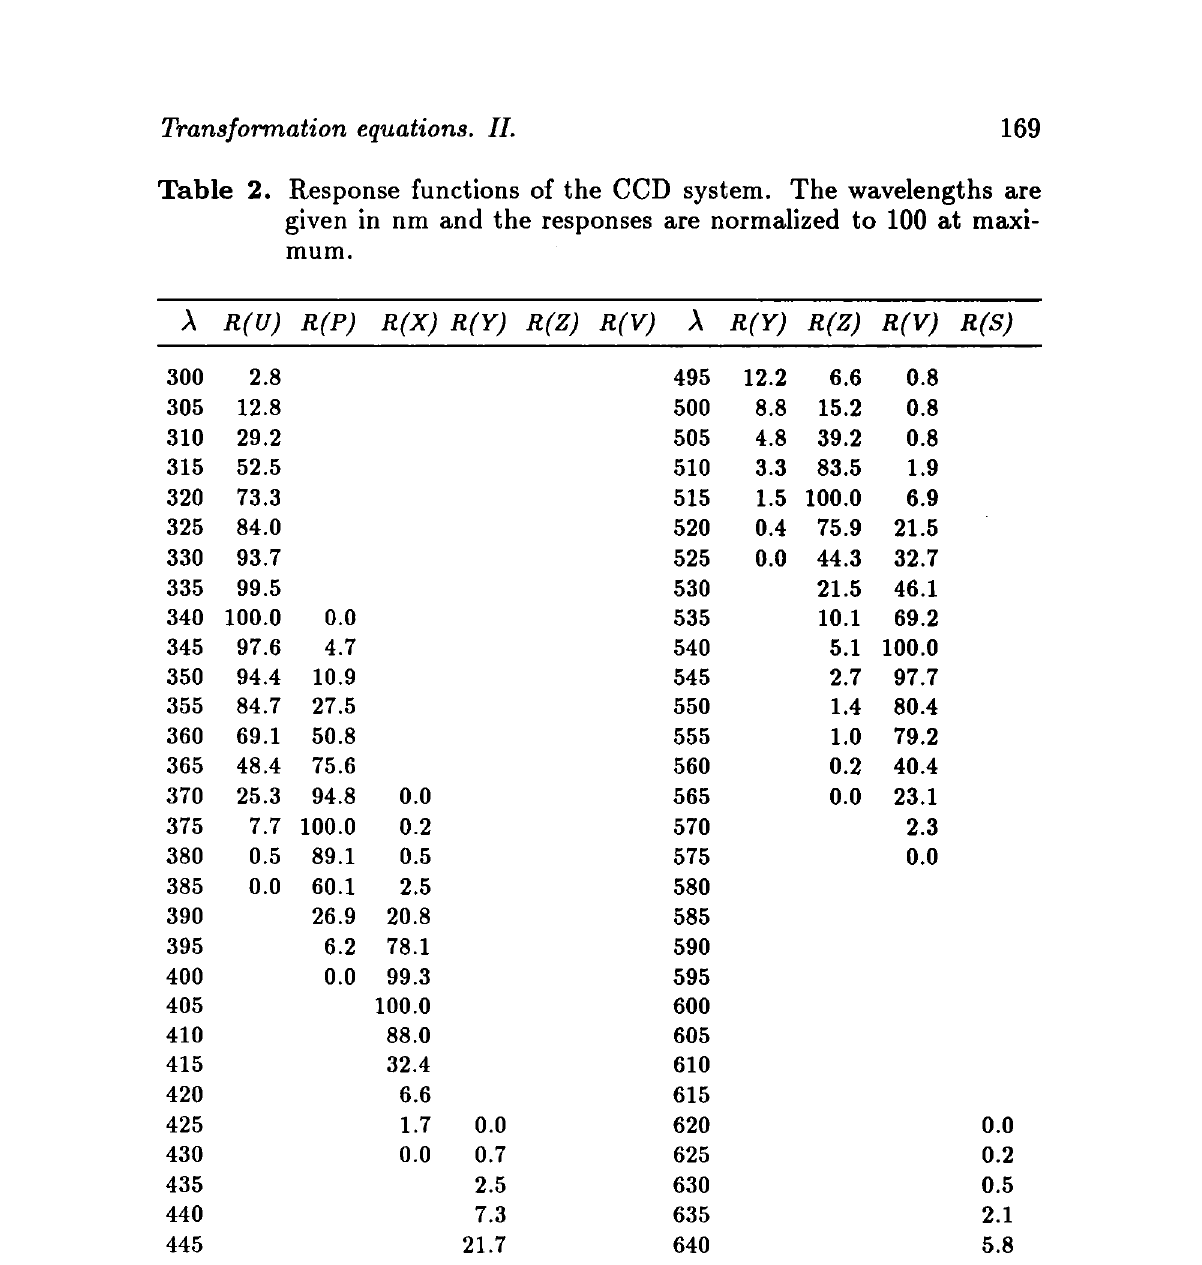
Table 2. Response functions of the CCD system. The wavelengths are given in nm and the responses are normalized to 100 at maxi-